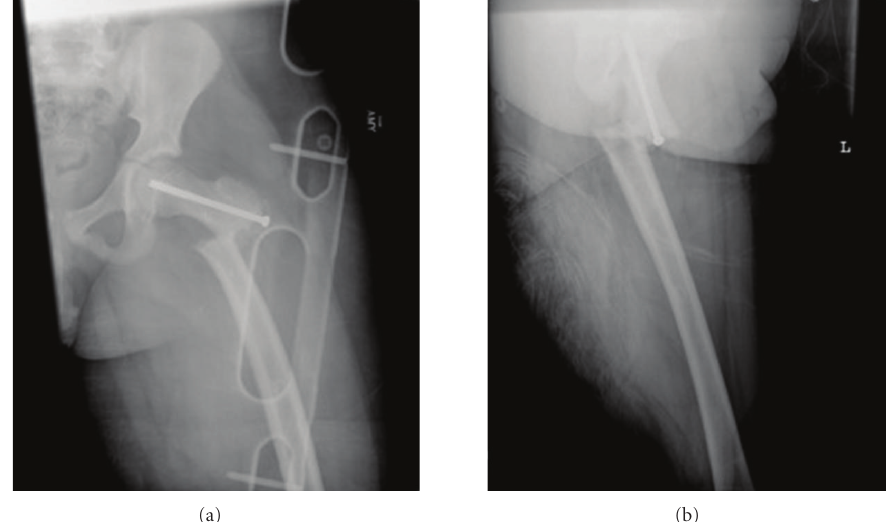
Figure 1: AP (a) and lateral (b) radiographic views of the left hip and thigh after the patient fell o ff his bicycle.